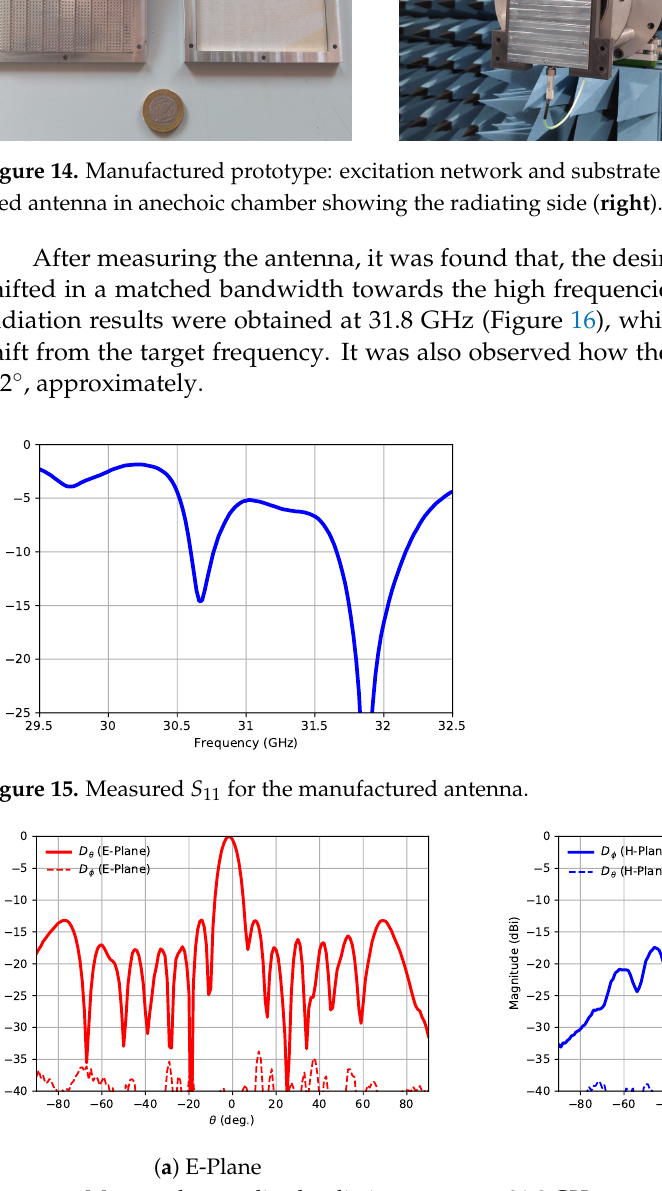
Figure 16. Measured normalized radiation pattern at 31.8